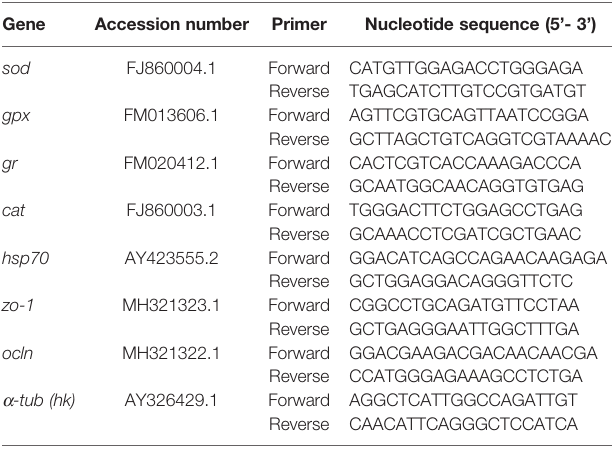
TABLE 2 | Primers used for